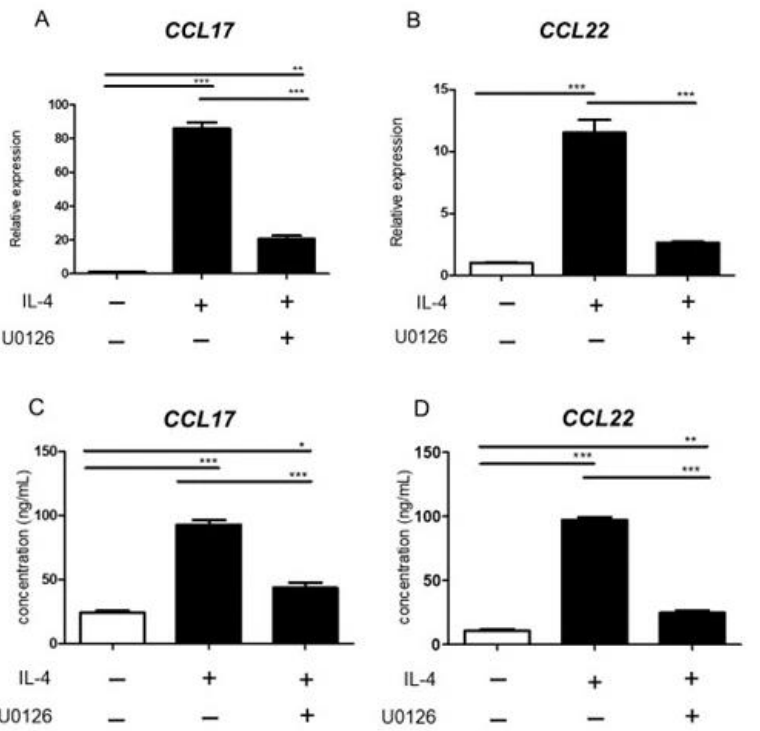
Figure 6. ERK inhibitor inhibited chemokine production from BMDC induced by IL-4. BMDCs were treated with IL-4 (20 ng/mL) in the presence or absence of ERK inhibitor. ( A , B ) CCL17 and CCL22 mRNA expression was analyzed by qRT-PCR. ( C , D ) CCL17 and CCL22 protein expression was analyzed by ELISA. All data are presented as mean ± S.E.M. (n = 3 per each group). * p < 0.05, ** p < 0.005, *** p < 0.001 one-way analysis of variance followed by Bonferroni’s multiple comparison test.